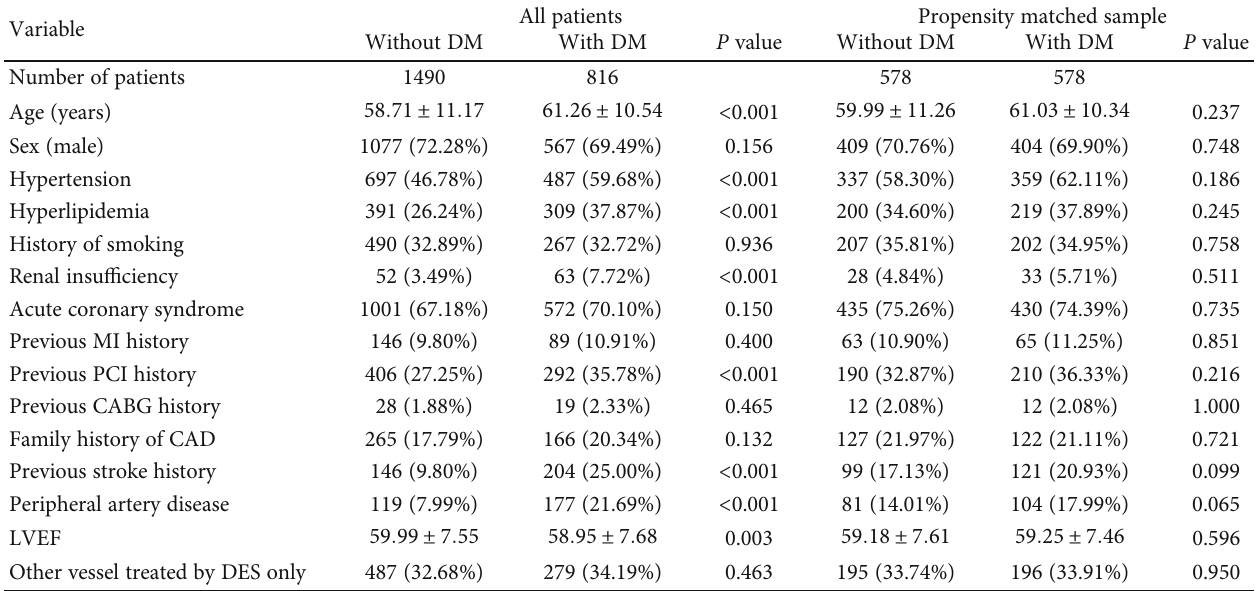
Table 1: Demographic characteristics before and after propensity score matching.